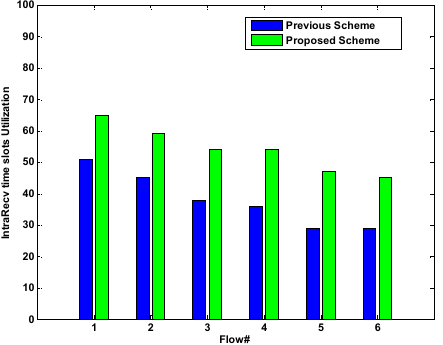
Figure 10. IntraRecv time slot utilization.